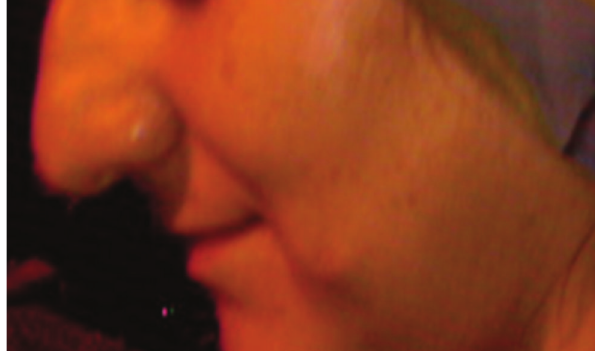
Figure 1: A 34-year-old female was admitted with a slowly growing nodular lesion at the left nasolabial region for three years.